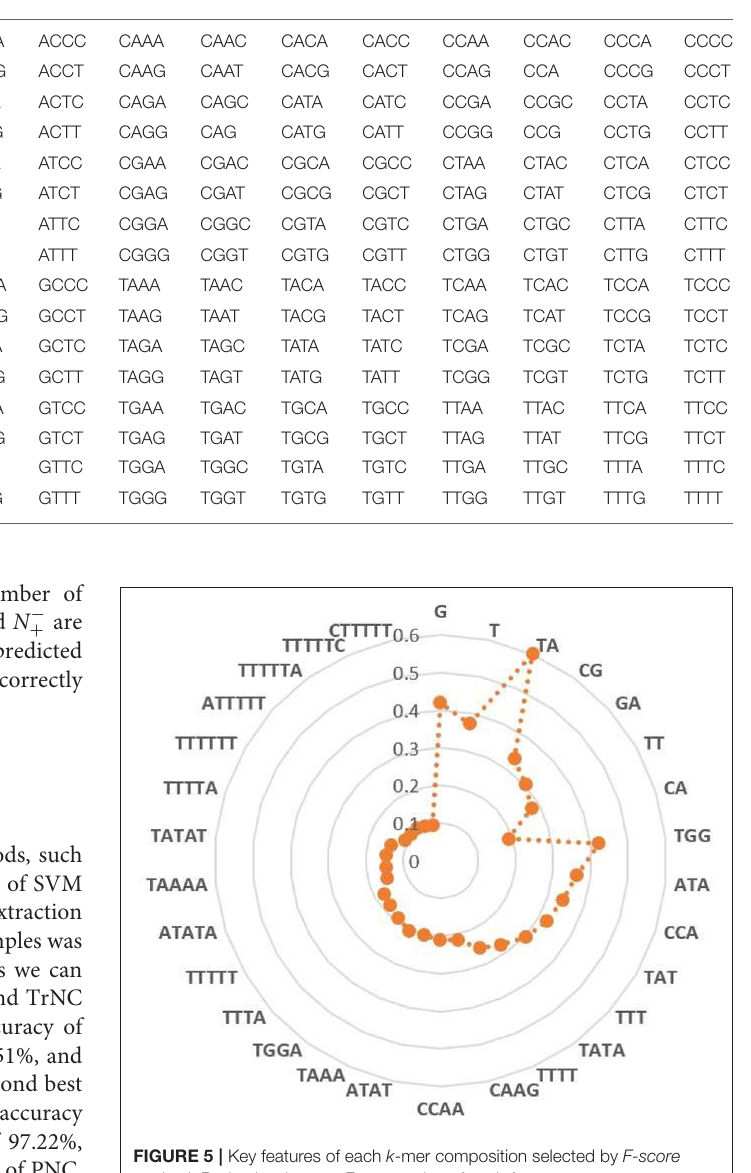
FIGURE 5 | Key features of each k -mer composition selected by F-score method. Red color denotes F-score value of each